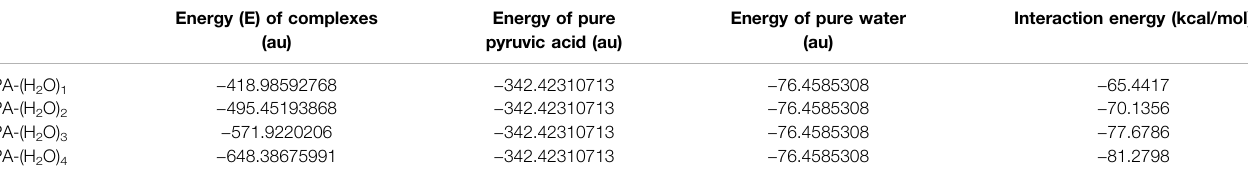
TABLE 2 | Energy spectrum of different pyruvic acid – water complexes calculated by the DFT/B3LYP method at the 6- 311++G(d, p) basis set. Energy (E) of complexes Energy of pure Energy of pure water Interaction energy (au) pyruvic acid (au) (au)